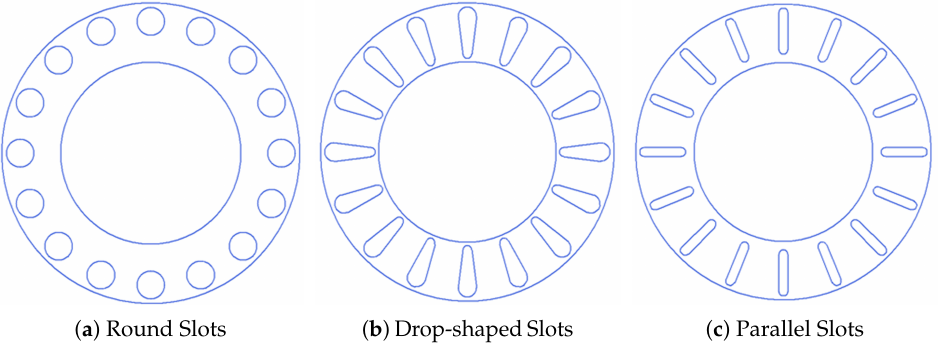
Figure 11. Slot Types of the Laminated